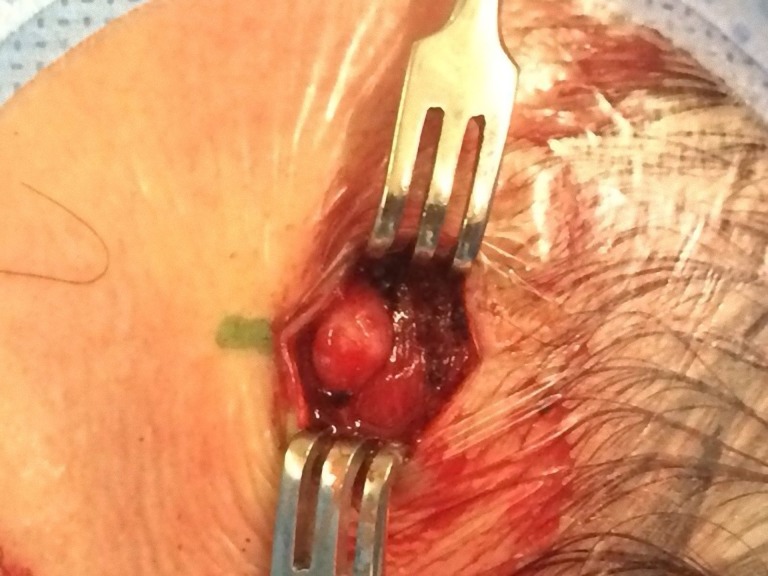
Surgical wound revealing an aneurysm of the temporal artery.